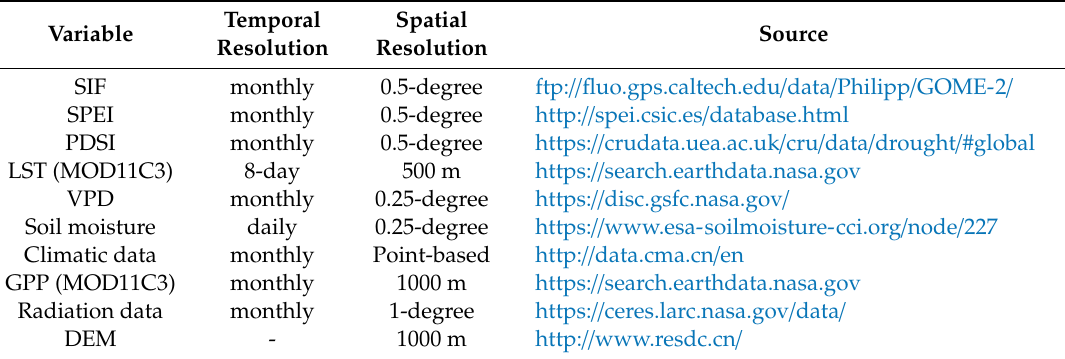
Table 1. Details of collected datasets used in this